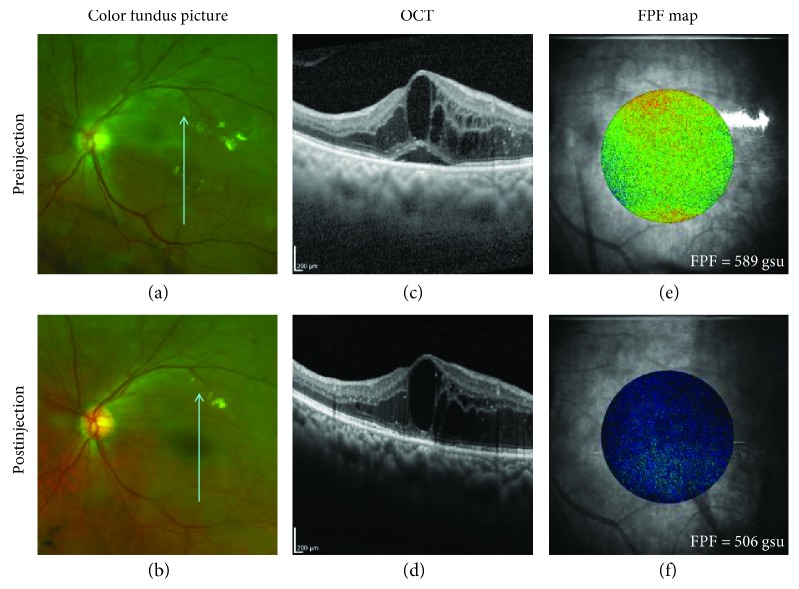
Subject 008, 65 y/o Hispanic male diagnosed with PDR and CSME. (a, b) Color fundus picture shows macular edema, hard exudates, and hemorrhages. (c) OCT CMT preinjection (574 μm); (d) OCT CMT postinjection (541 μm). (e) FPF map preinjection shows an increase in green-yellow coloring suggesting greater mitochondrial dysfunction (oxidative stress) compared to the (f) blue-green postinjection FPF map. gsu = grayscale units.